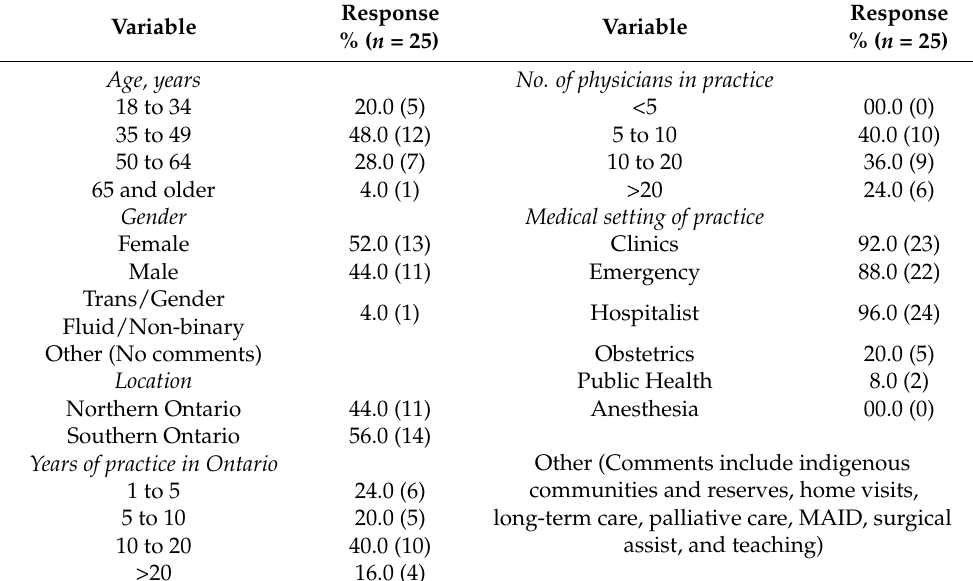
Table 1. Demographics of